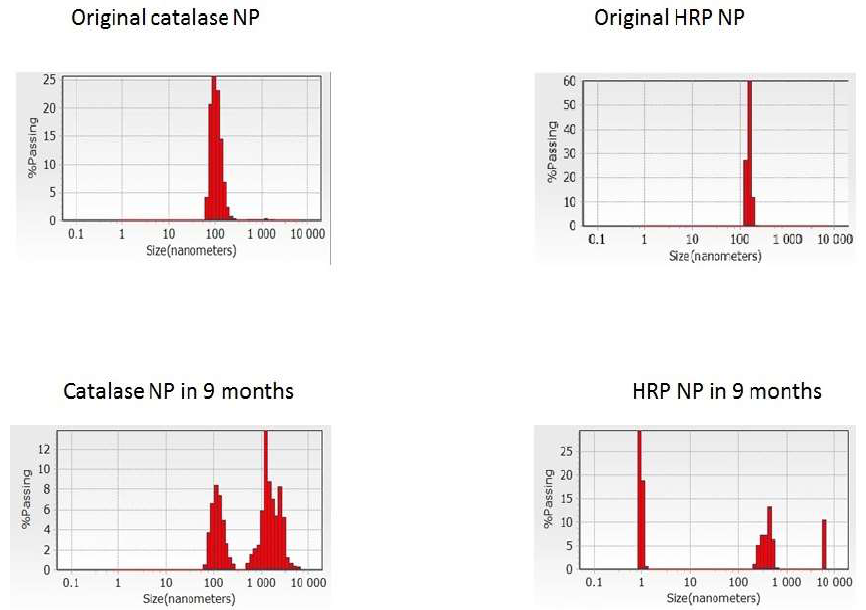
Figure 4. Dynamic light scattering (DLS) measurements of the catalase and HRP NP sizes before and after storage in water for 9 months.